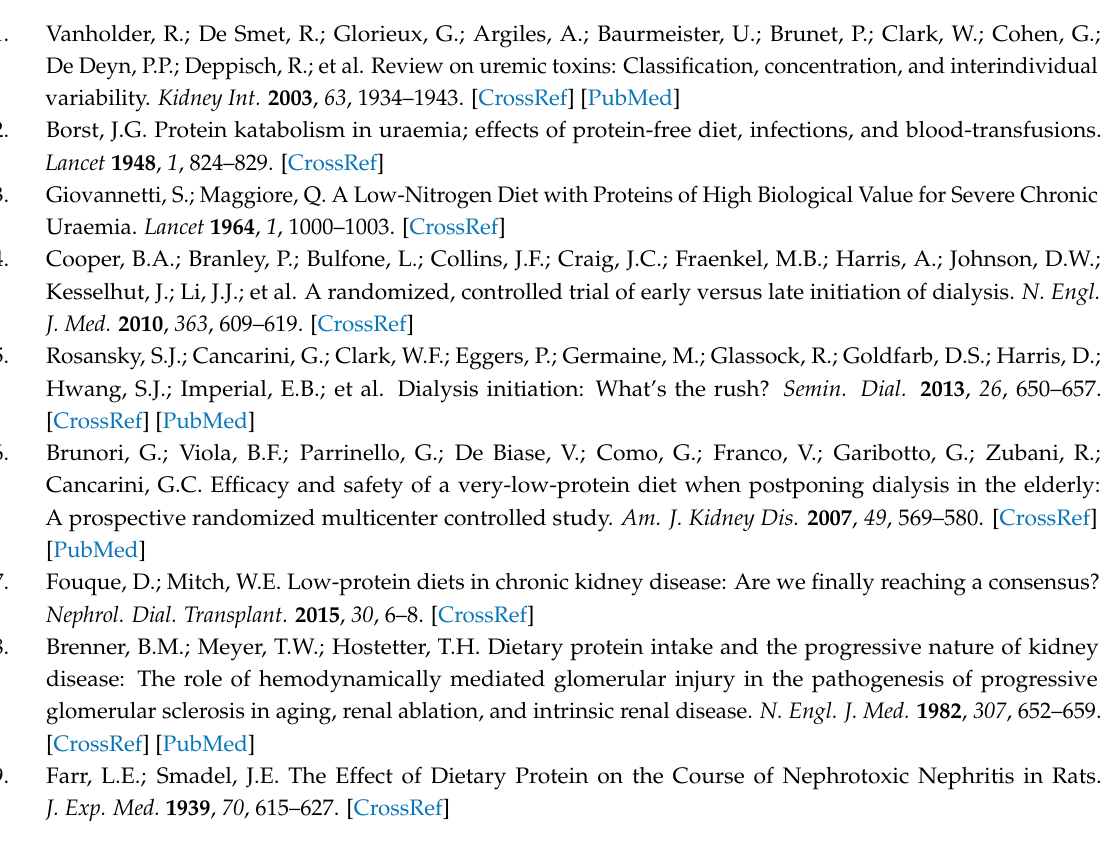
Table S1: Sensitivity analysis for the effect of DPI on renal survival. Table S2: Association between DPI and PEW components. Figure S1: Development of renal events according to the stage of chronic kidney